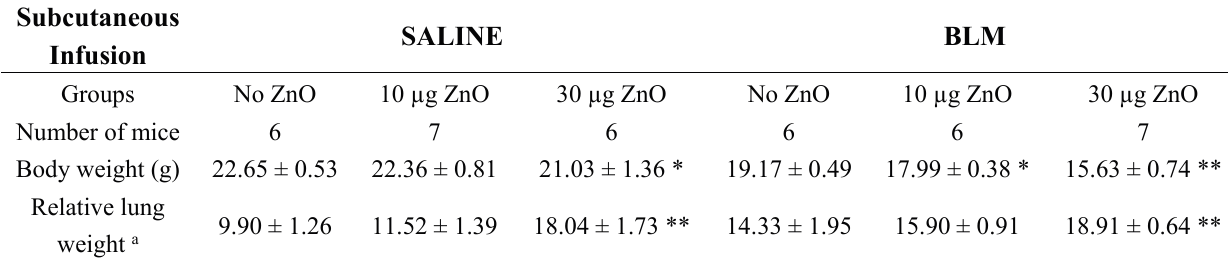
Table 1. Comparison of body weight and relative lung weight at Day 10 after administration. Data are the mean ± SD; * p < 0.05; ** p < 0.01; compared with the vehicle control. a The relative lung weight is the value of the lung weight (mg) divided by the body weight (g). BLM, bleomycin; ZnO, zinc oxide.